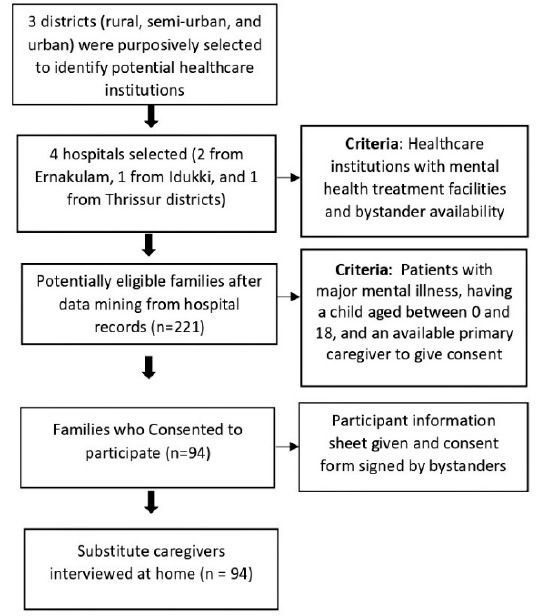
Figure 1. Participant recruitment for the study.